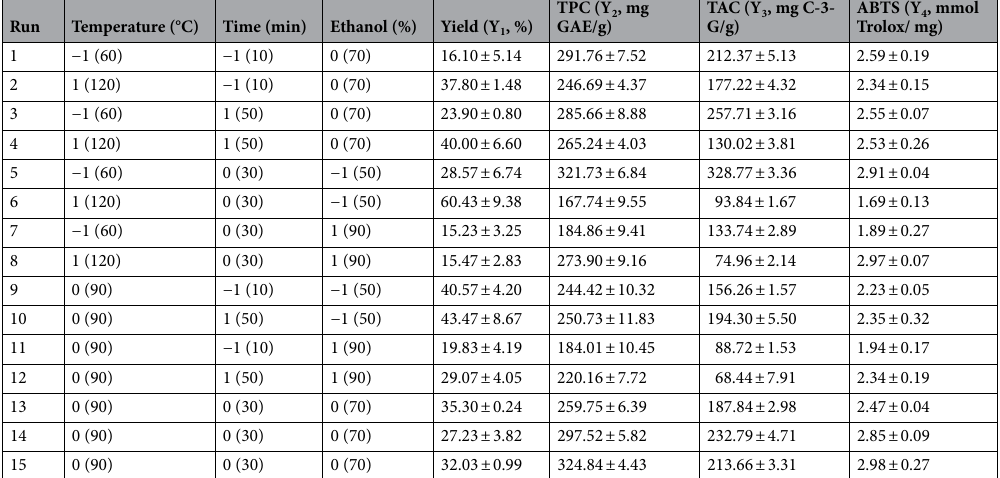
Table 1. Box–Behnken design for independent variables and observed responses. TPC total phenolic content, mg GAE/g milligram gallic acid equivalents per gram extract, TAC total anthocyanin content, mg